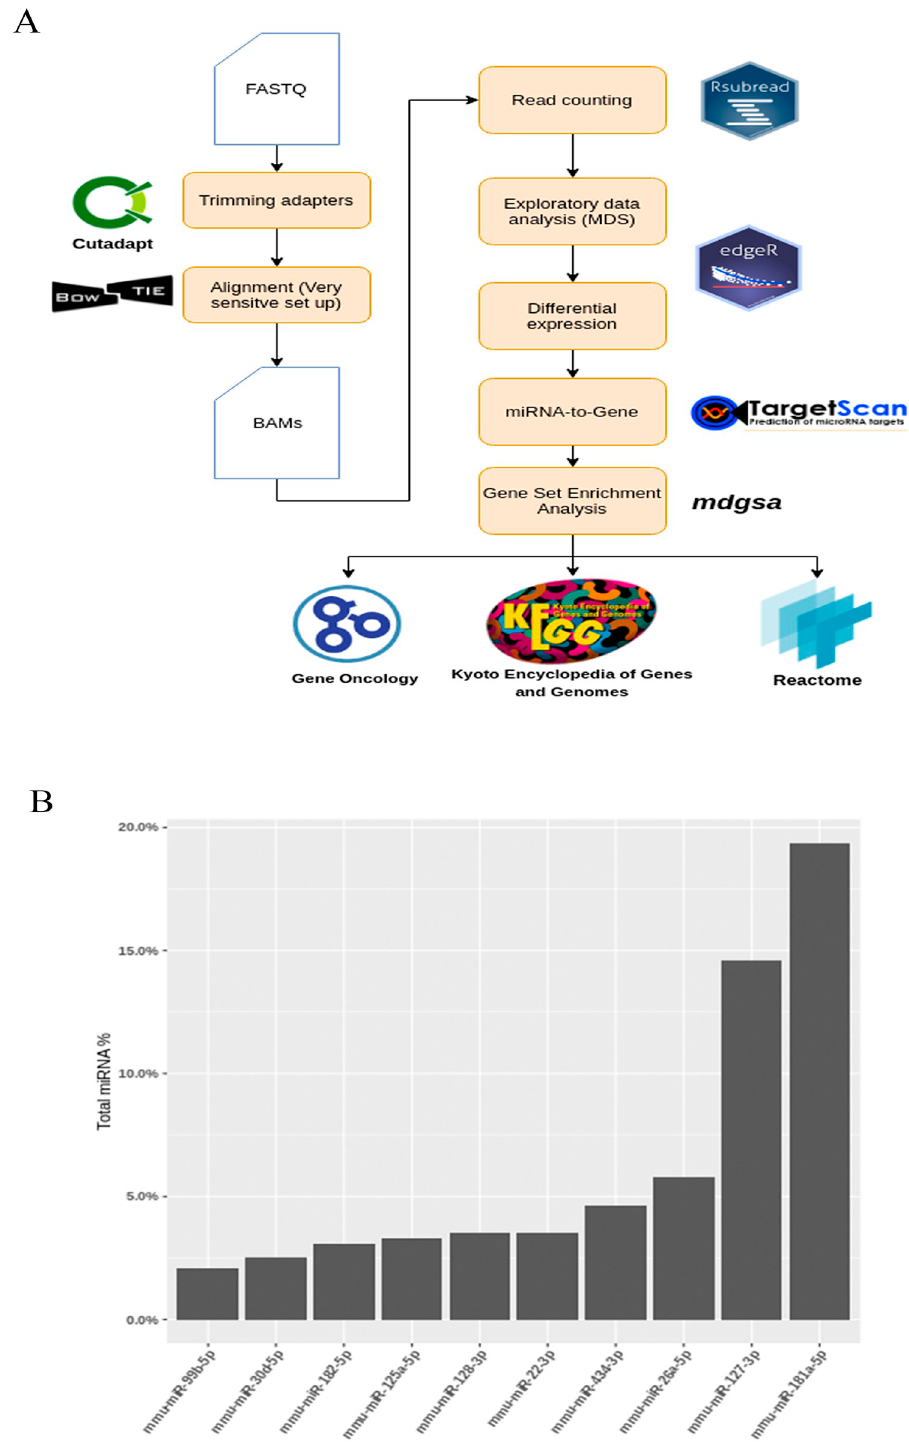
Fig 2. Bioinformatics analysis and mature miRNA profile of samples: ( A ) Pipeline methodology used (see page 8). ( B ) The Top 10 abundant mature miRNA in samples, which were almost 50% of the total counts of the following mature miRNA: mmu-miR-181a-5p, mmu-miR-127-3p, mmu-miR-26a-5p, mmu-miR-434-3p, mmu-miR-22-3p and mmu- miR-128-3p.